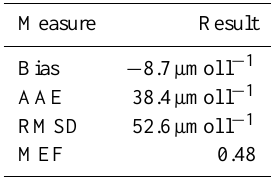
Table 4. Oxygen model assessment